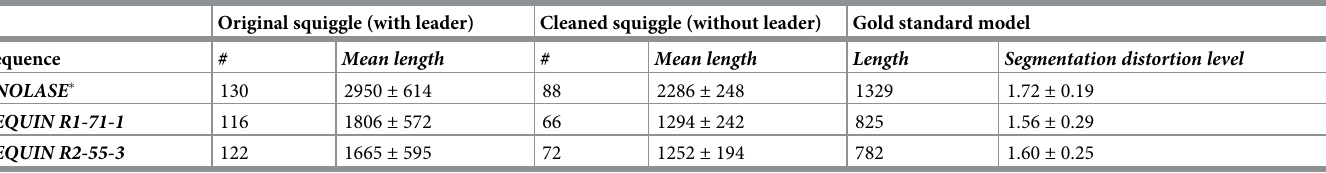
Table 1. Comparison of the length characteristics of the original and cleaned data sets. There is an equivalent x1 . 7 length distortion level introduced into all data sets. � To generate a valid cross-comparison, only 130 of the available 7000 + Enolase squiggles were included in this analysis. Original squiggle (with leader) Cleaned squiggle (without